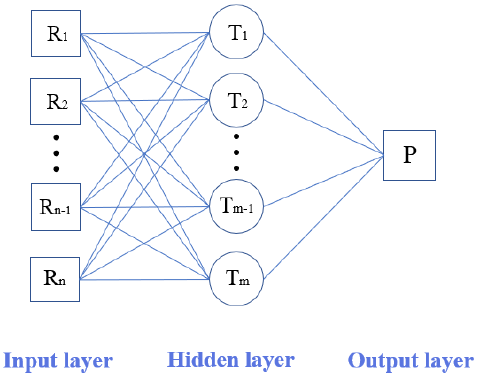
Figure 1. The architecture of neural network predictor model.